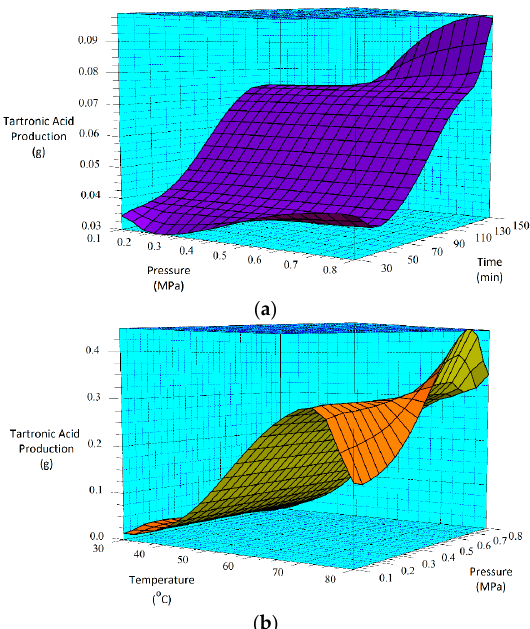
Figure 7. 3D surface plots for tartronic acid production for ( a ) the 30-min and ( b ) the 60-min as-deposited electroless CuNiMoP/Al 2 O 3 oxidation reactions.